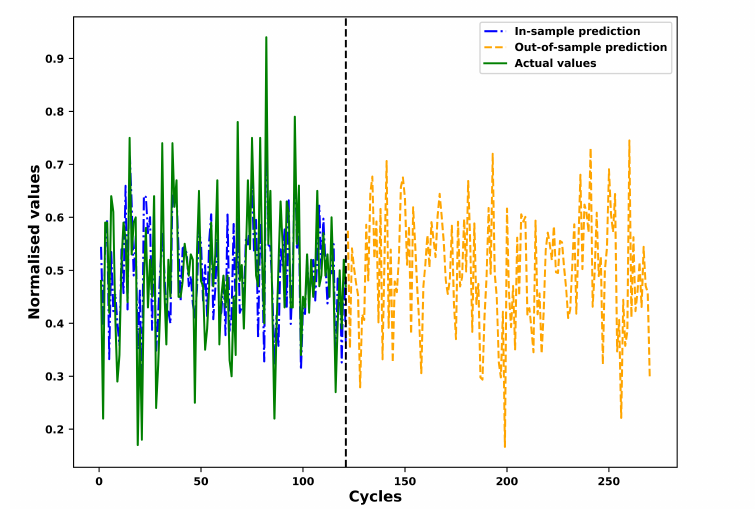
Figure 9. Prediction of the first operational conditions of the unit 37 in FD001 test sets based on the FGM(1, 1) and ARIMA/ARMA calibration.